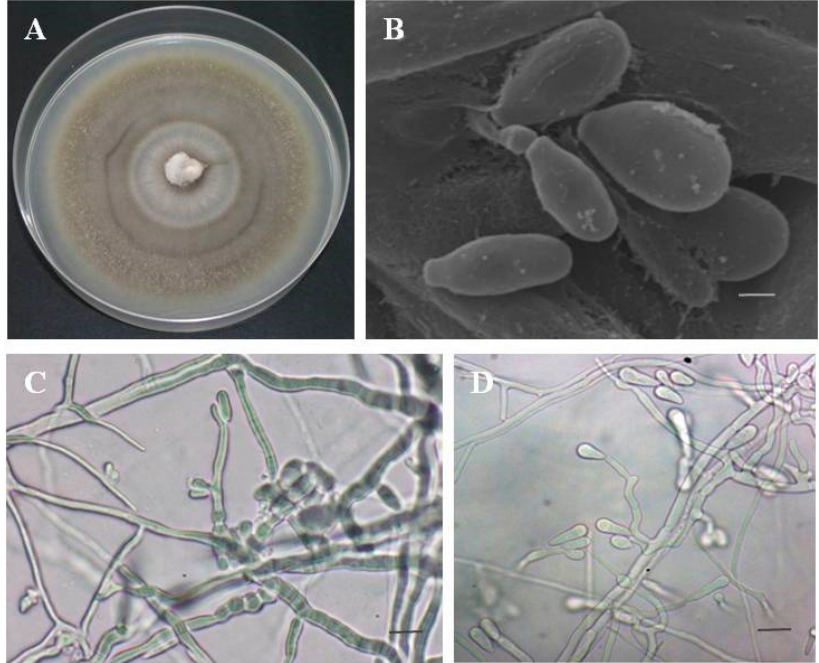
Figure 5. Culture, conidiophores and conidia of Raffaelea quercina sp. nov. (isolate PC05.042 = MEAN 1292) ( A ) Colony morphology after 2 weeks on malt extract agar in a 90 mm diameter plate. ( B ) Scanning electron micrograph showing ovoid conidia (bar = 1 µ m) ( C , D ). Light micrographs of conidia and conidiogenous cells without conspicuous scars from conidial dehiscence (bar = 10 µ